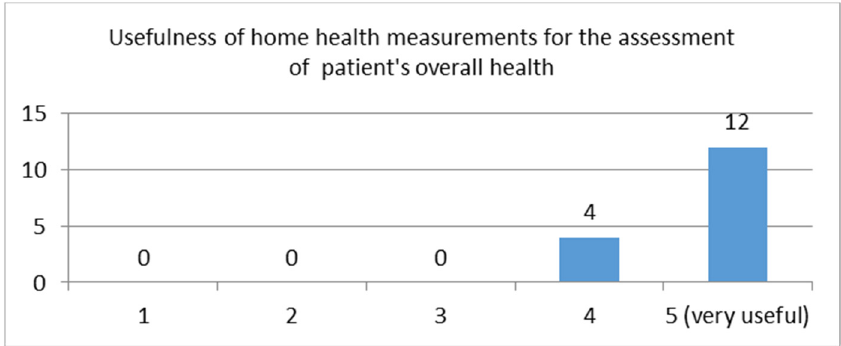
Figure 4. Distribution of rating scores for the usefulness of information captured by medical and non-medical devices for the clinical assessment of a patient’s overall health.